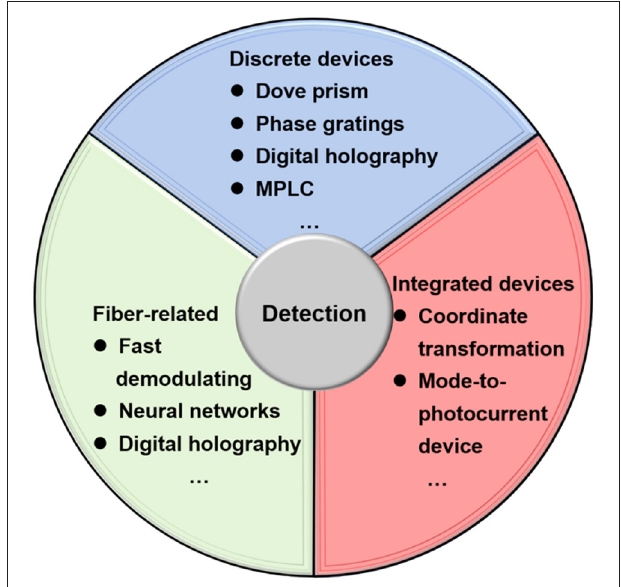
FIGURE 6 | Methods and devices for detection of spatial-structured light beams. MPLC, multiplane light